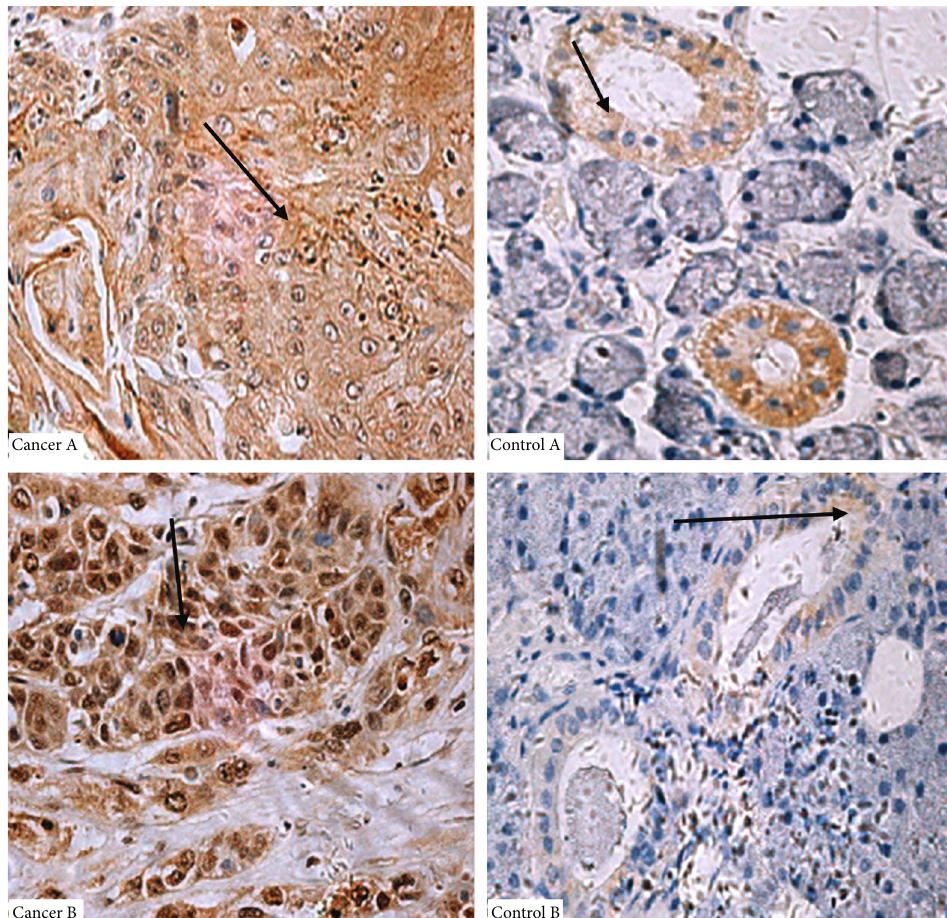
Figure 3: EGFR levels of expression in head and neck control tissues (right) were compared with their corresponding head and neck tumor tissues